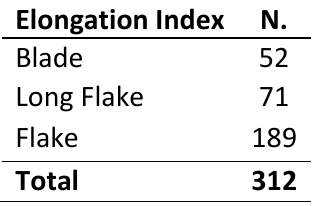
Table 2. Elongation index of target objects.